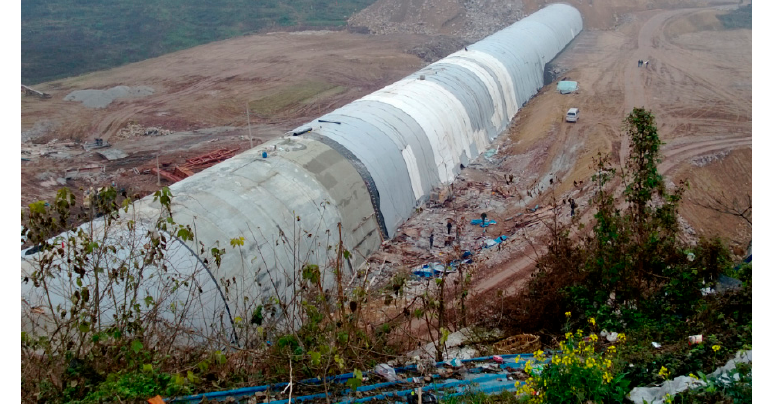
Figure 4. Backfilling range (half side).